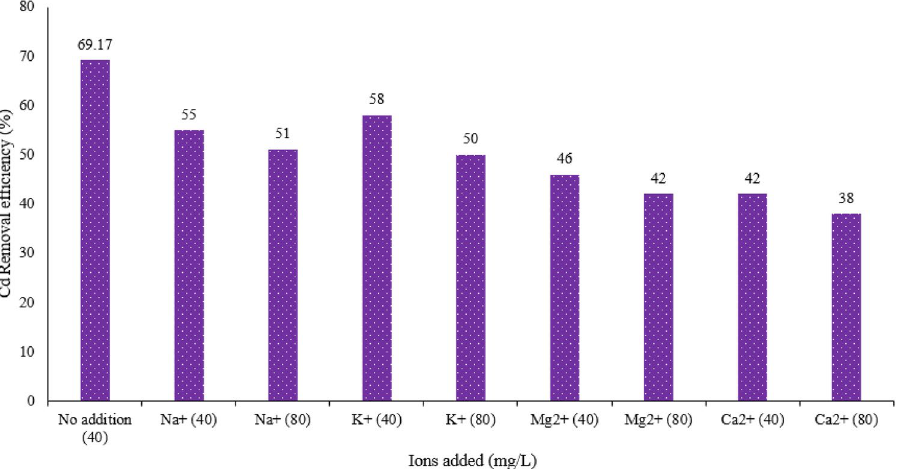
Figure 11. Effect of sodium, potassium, magnesium and calcium ions on the removal of Cd(II) by the MBA nano-hybrid (pH = 7.0, adsorbent = 1.0 g/L, temperature = 25 °C, time = 60 min).